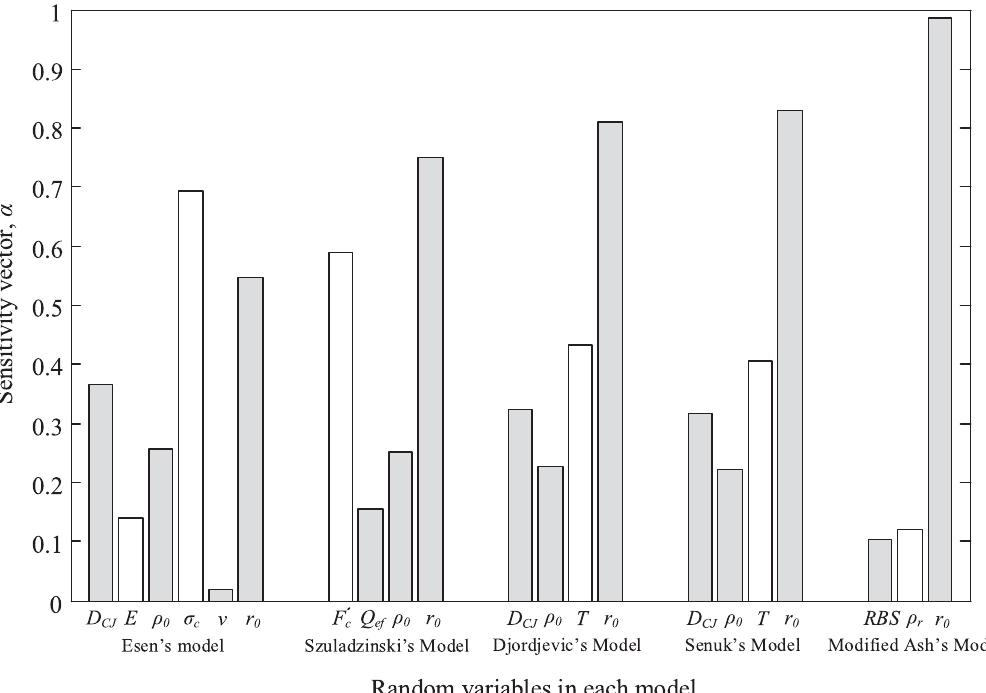
Figure 10. The relative importance of parameters involved in various Figure 16. Relative importance of involved random variables in each model.